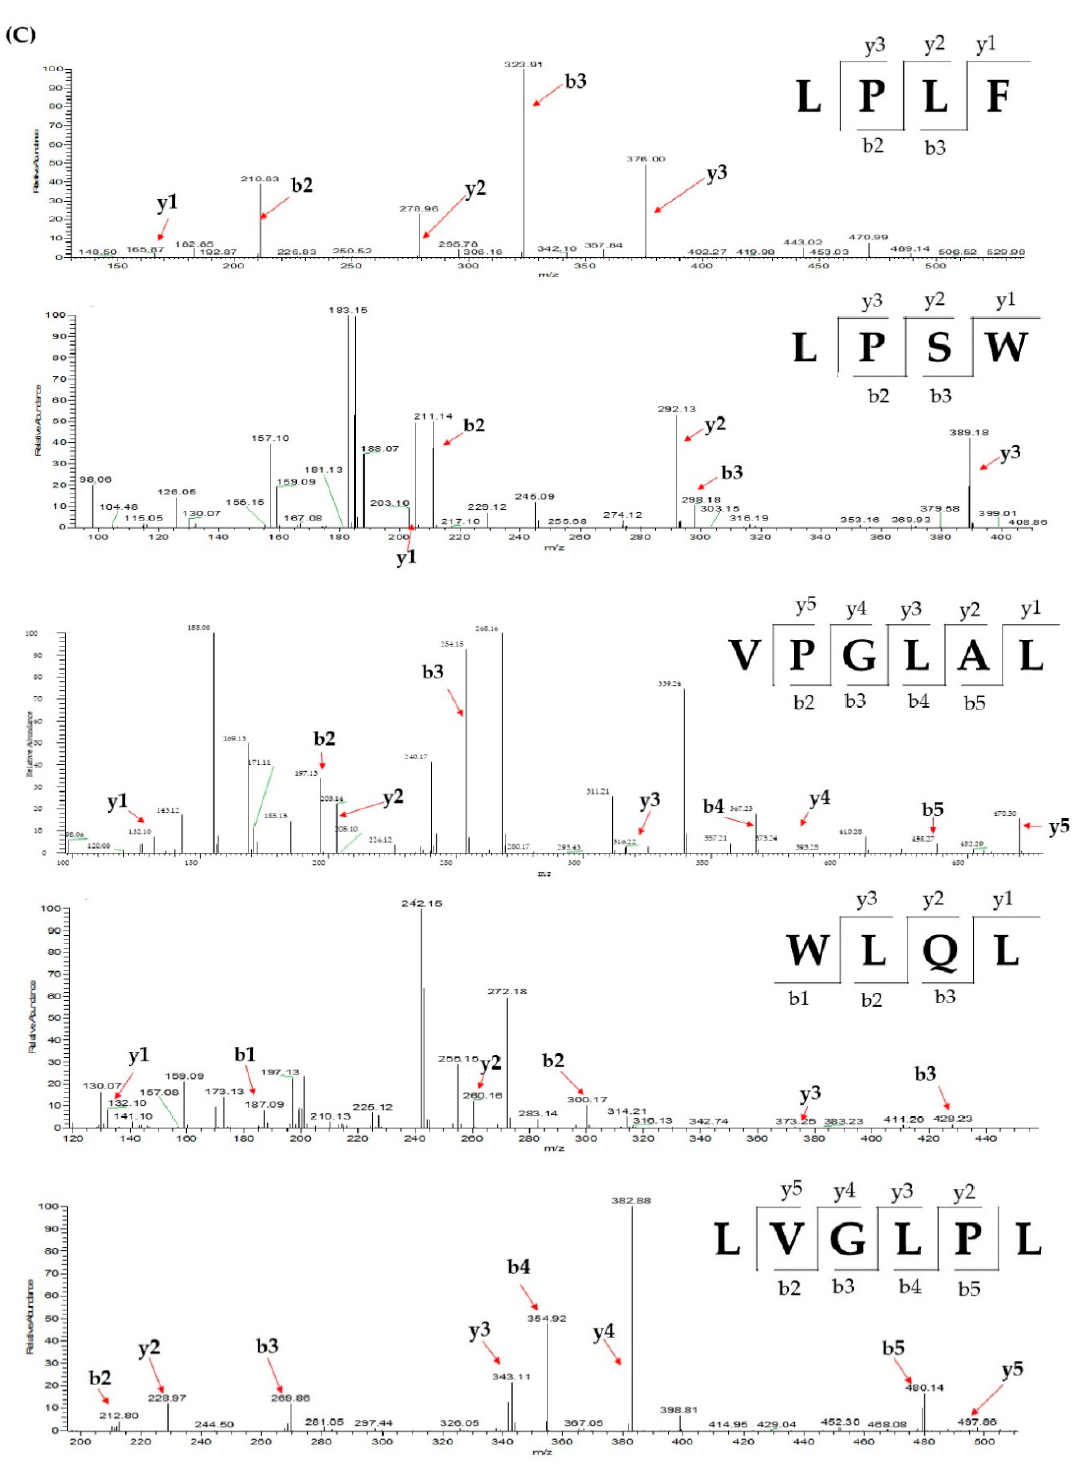
Figure 3. ( A ) The distribution of five overlapping peptides in LC-MS chromatogram of SCX-S2 fraction; ( B ) MS spectra of LPLF ( m / z 489.31 at t R = 32.31 min), LPSW ( m / z 502.27 at t R = 29 min), VPGLAL ( m / z 569.37 at t R = 30.31 min), WLQL ( m / z 559.32 at t R = 33.05 min), and LVGLPL ( m / z 611.41 at t R = 35.30 min); ( C ) MS / MS spectra of the peptide with m / z 489.31, 502.27, 569.37, 559.32, and 611.41, respectively. The b- and y-series ions in the MS / MS spectra indicate the fragment ions of the peptides.